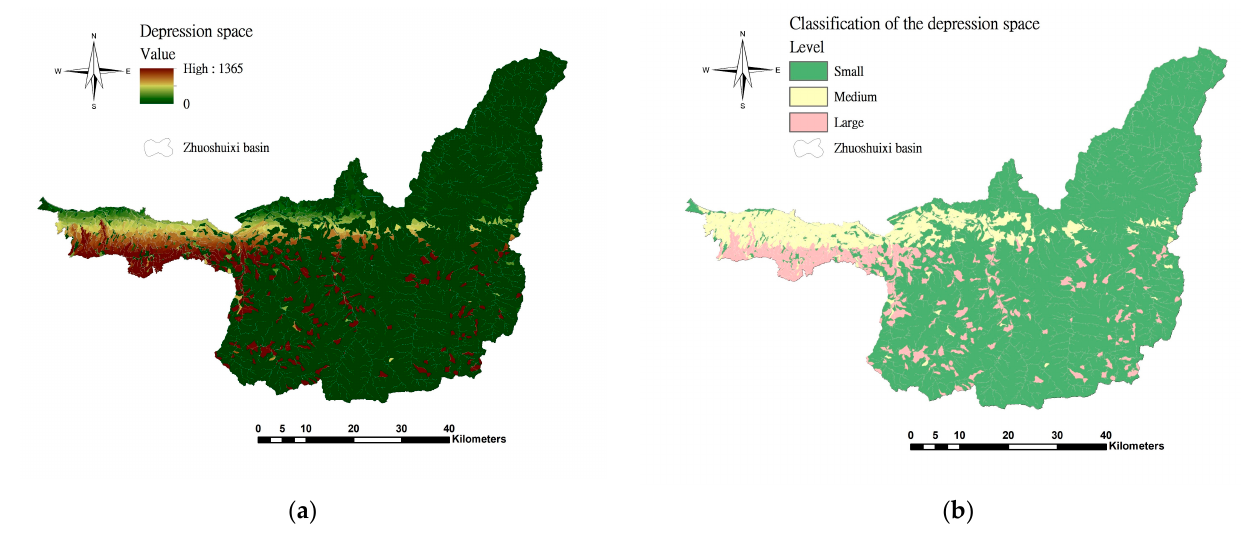
Figure 12. ( a ) Depression space distribution and ( b ) depression space classification.